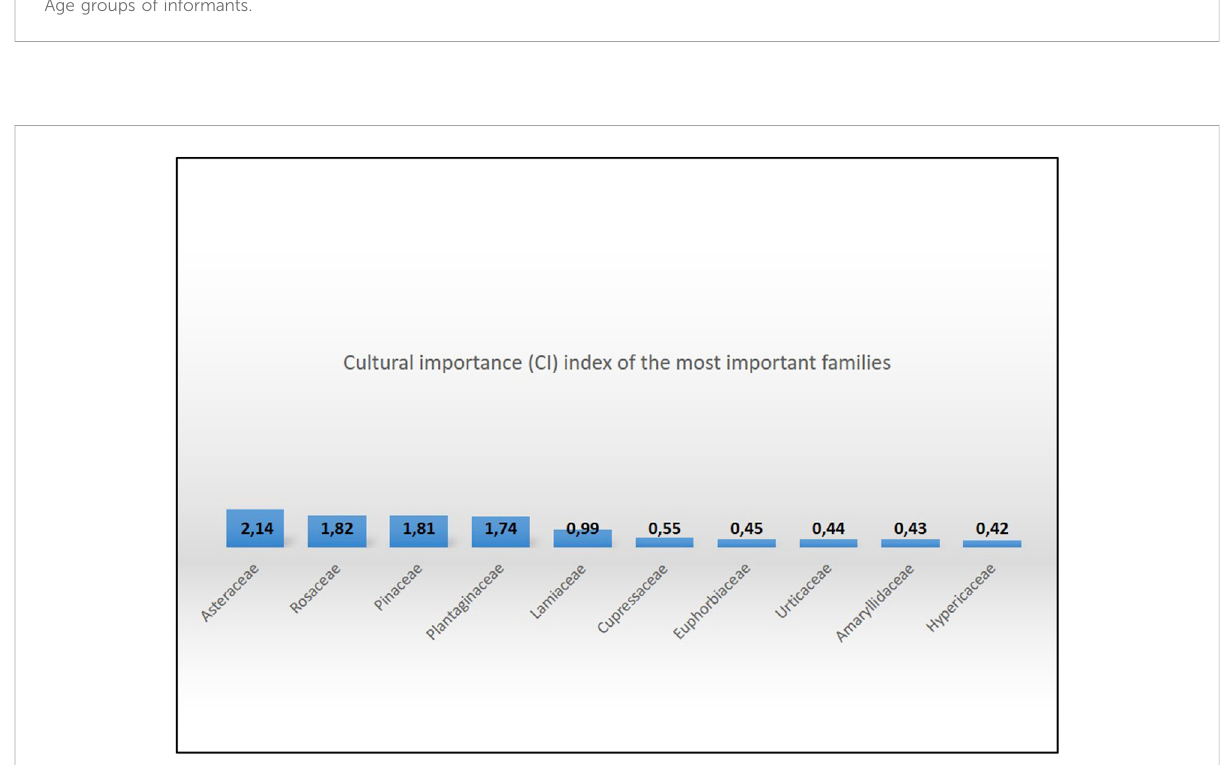
FIGURE 5 Cultural importance (CI) index of the 10 most important families in Ta ş